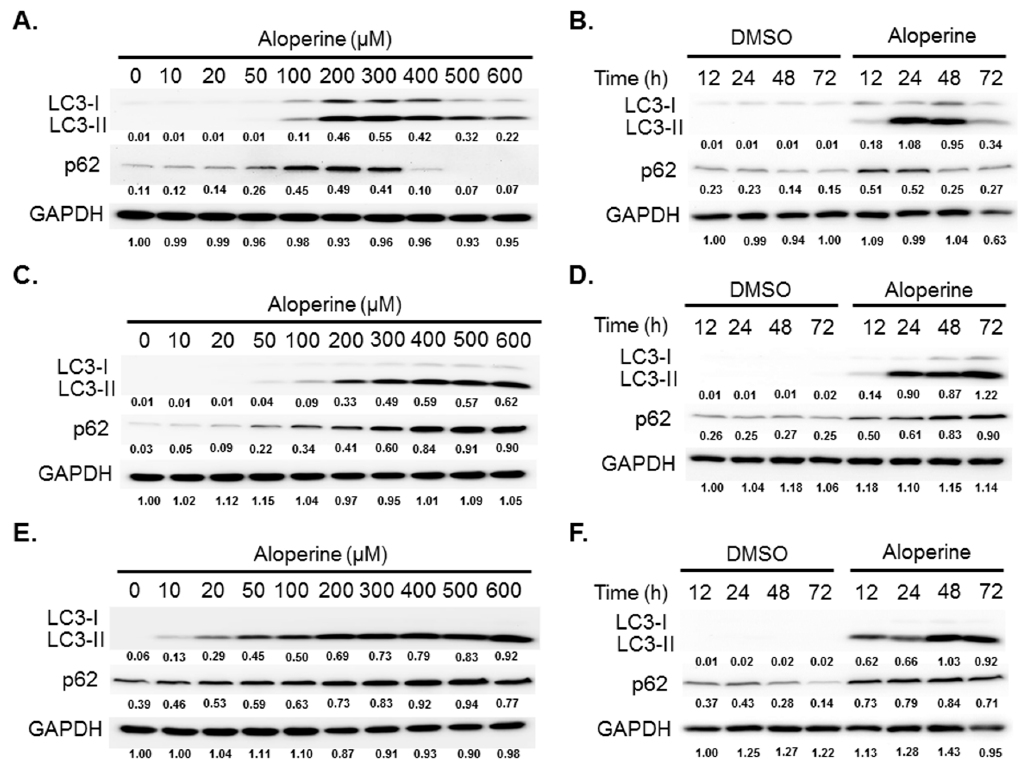
Figure 2. Autophagy modulation in human thyroid cancer cells following aloperine treatment. ( A , B ) KMH-2, ( C , D ) 8505c, and ( E , F ) IHH-4 cells were incubated with aloperine, and LC3-II and p62 expression was determined using western blotting ( A , C , E ). Data are shown for cells incubated with aloperine for 24 h. ( B , D , F ) Data are shown for cells treated with DMSO or aloperine (200 µ M). Numbers under the plots indicate the quantification of protein intensity after normalization with GAPDH. Three independent experiments were performed, and results of one of these are